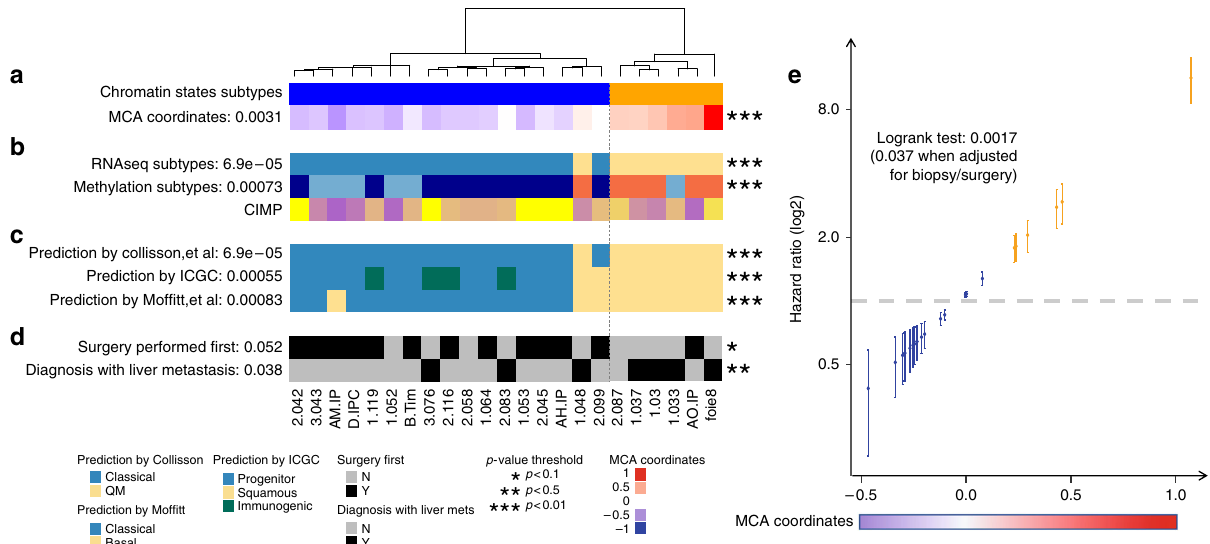
Fig. 2 Epigenomic landscapes predict patient outcomes. a Chromatin state-based clustering using epigenetic regions associated with the second MCA component demonstrates two subtypes. Sample coordinates in this dimension and Student ’ s t -test p -value of the association with chromatin state-based clustering are indicated. b Clustering of RNA-seq and DNA methylation data into subtypes is shown by distinct colors and plotted according to chromatin state-based clustering from a . p -values of Fisher ’ s exact test demonstrate the association with chromatin state-based clustering. CIMP, CpG Island Methylator Phenotype calculated as the mean of island-CpG methylation level. c Prediction of PDAC subtypes using transcriptome-based publically available signatures 12, 13 . d Clinical characteristics of PDAC samples based on status of surgical resection and presence of liver metastasis at diagnosis and p -values of Fisher ’ s exact test are indicated to show the association of clinical data with the chromatin state-based clustering. e Hazard Ratio (log2) estimated by a Cox model to demonstrate risk of death is shown along the MCA dimension. Dots are colored according to the chromatin